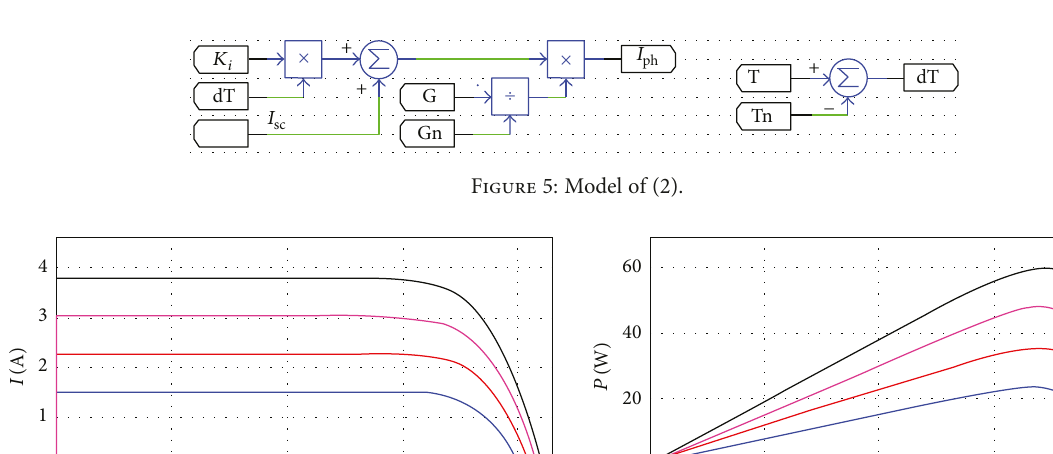
Figure 4: I ‐ V and P ‐ V characteristics of model and experimental